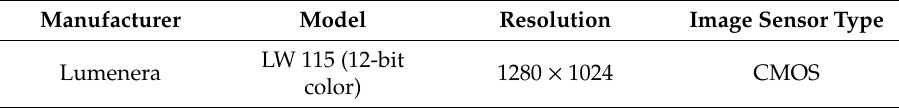
Table 5. Specification of the digital camera using the digital image correlation system.